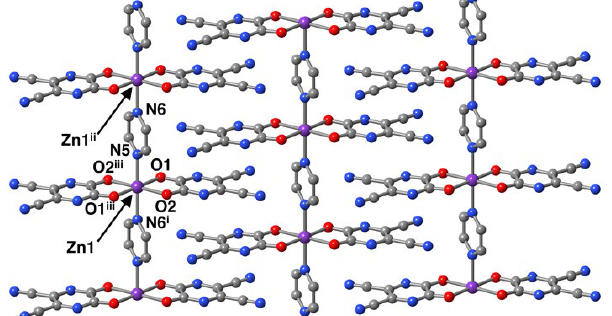
Figure 1. View of the arrangement of 1D chains of [Zn(CN 2 pyzdione) 2 (pyz)] 2– in the crystal packing of 1 with selective atom labeling, where purple, grey, blue, and red spheres represent Zn, C, N, and O atoms, respectively. H atoms have been omitted for clarity. i–iii denote symmetry codes: (i) x , y –1,